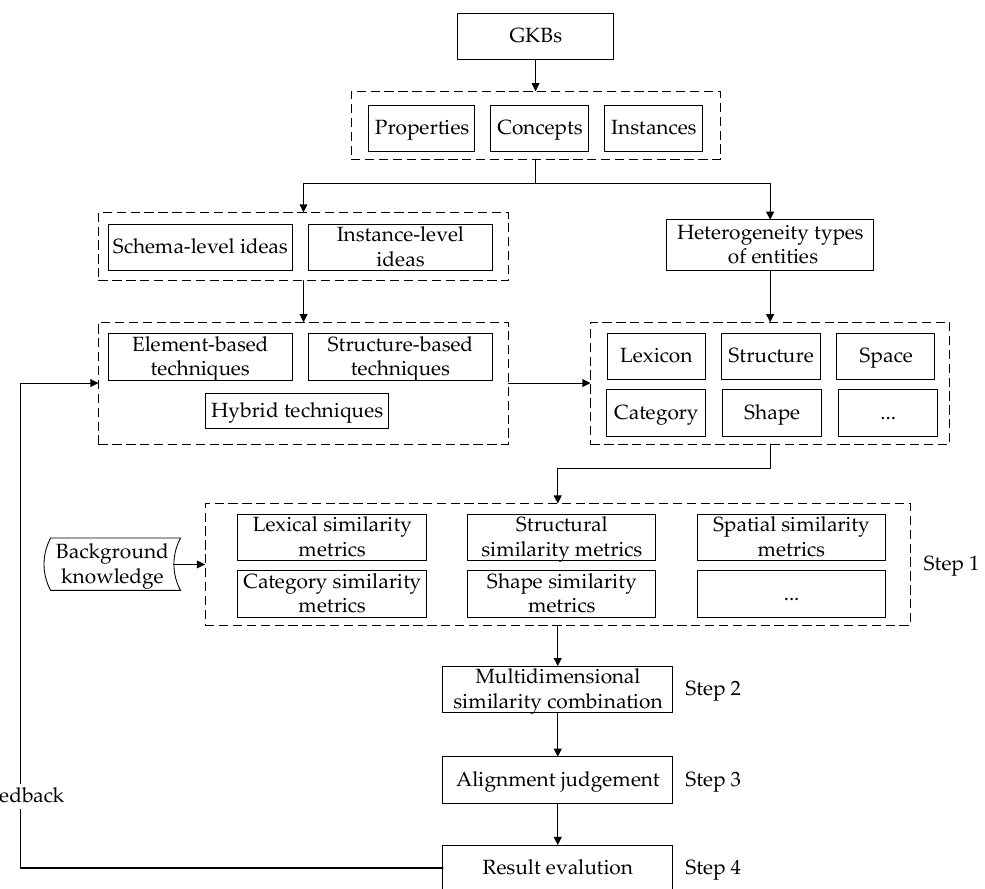
Figure 2. Standard workflow for entity alignment of GKBs.